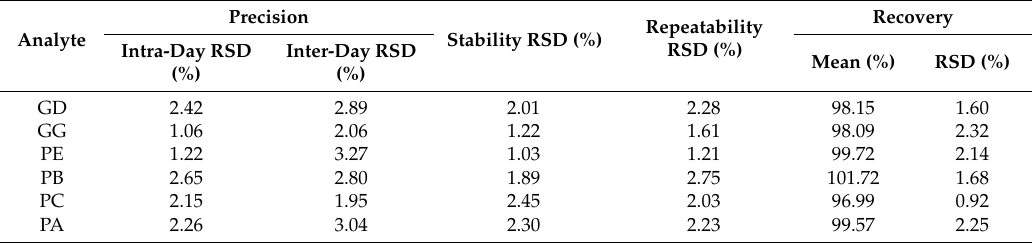
Table 2. RSD of precision, stability, repeatability and accuracy for determination of six gastrodin-type components.